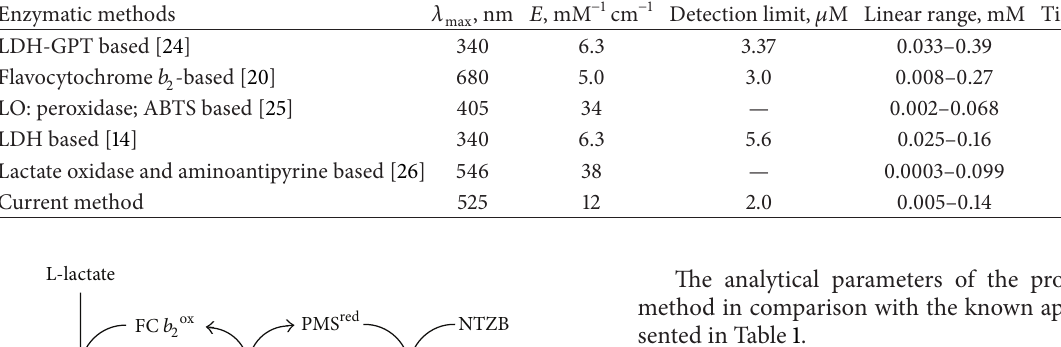
Table 1: Bioanalytical characteristics of different methods of L-lactate assay (calculated for concentrations in the final reaction mixture). Enzymatic methods